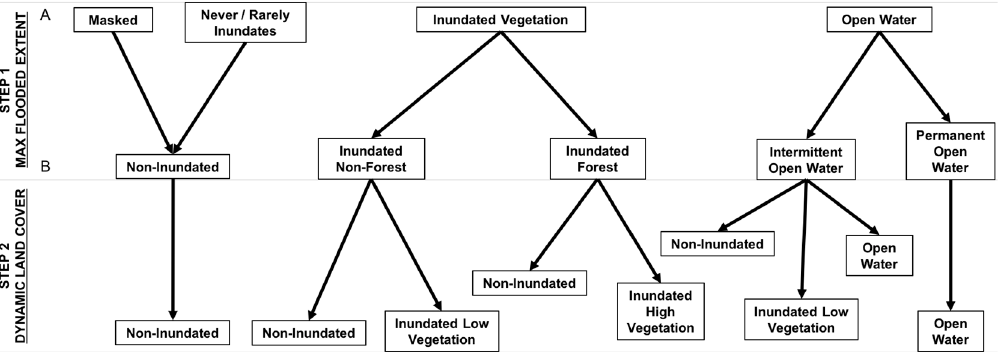
Figure 3. Two-step classification scheme used to classify static maximum flooded extent and dynamic land cover types and flooding status. The decision tree was implemented with thresholds derived from ROIs corresponding to associated homogenous land cover classes.